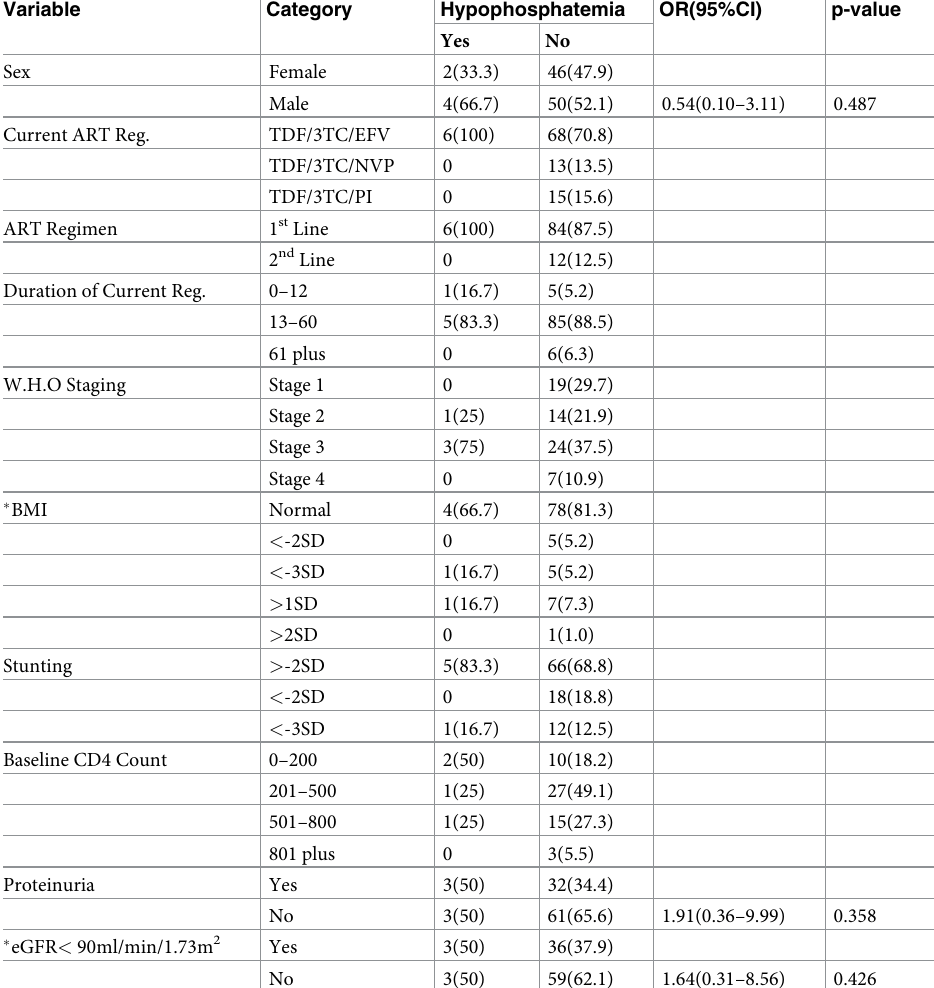
Table 5. Factors associated with hypophosphatemia in children � 14 years of TDF regimen for at least 6